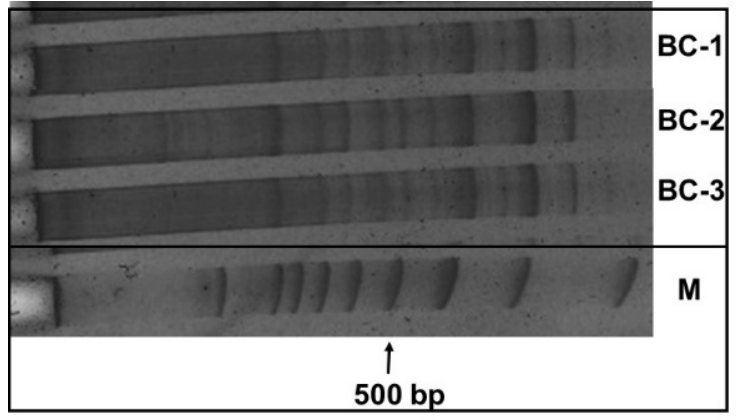
Figure 7. Cassandra profile of Bethune control variant in triplicate. A 1000 bp ladder was used (Fermentas).